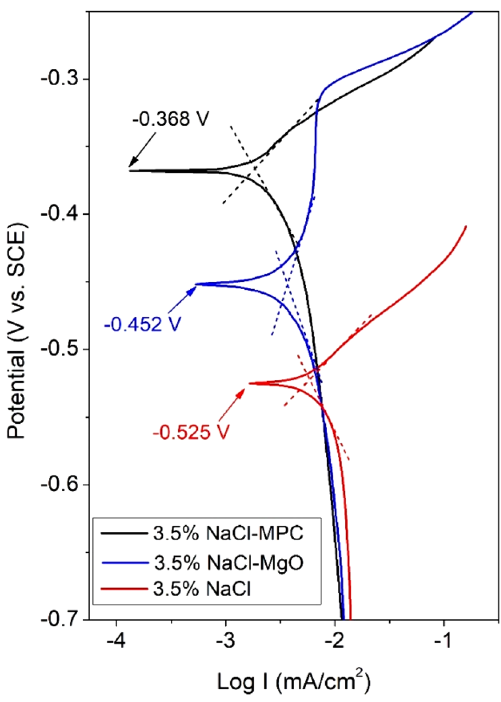
Figure 9. Tafel curves of uncoated mild steel panels immersed in three